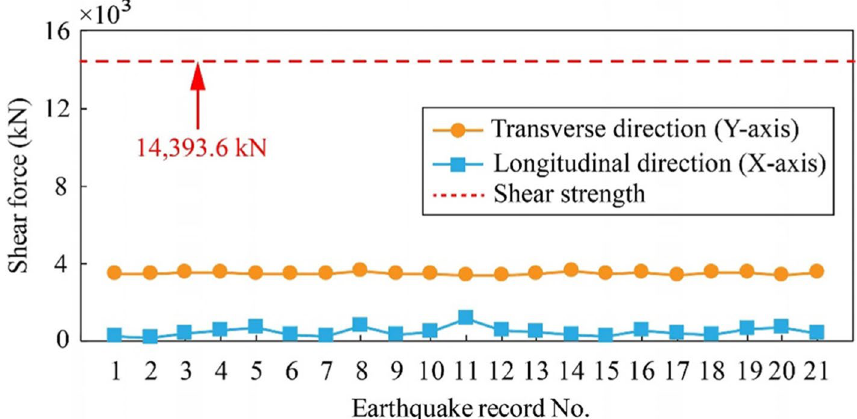
Fig. 9 Peak shear force at the pier bottom for various earthquake records under H